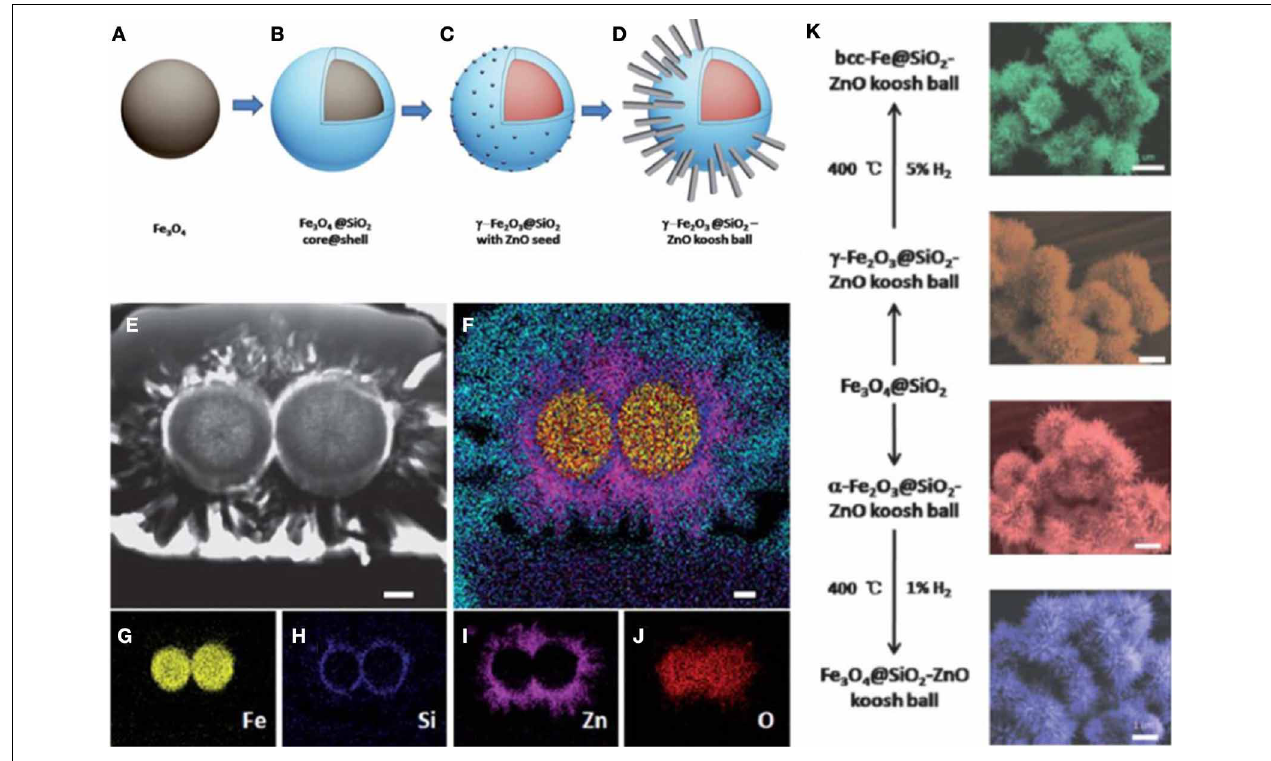
FIGURE 5 | (A–D) , Growth process for iron oxide@SiO2-ZnO nano koosh ball; (E–J) Elemental mapping of two koosh-ball structures using SEM-FIB dual-beam imaging system; (K) Tunable